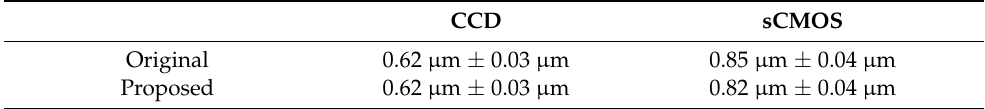
Table 3. Results of spatial resolution